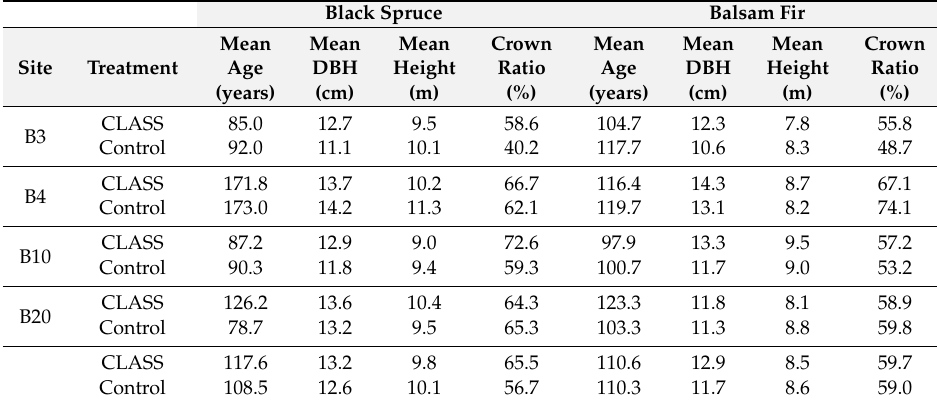
Table 2. Characteristics of the black spruce and balsam fir trees sampled in the CLASS and control plots in the four study